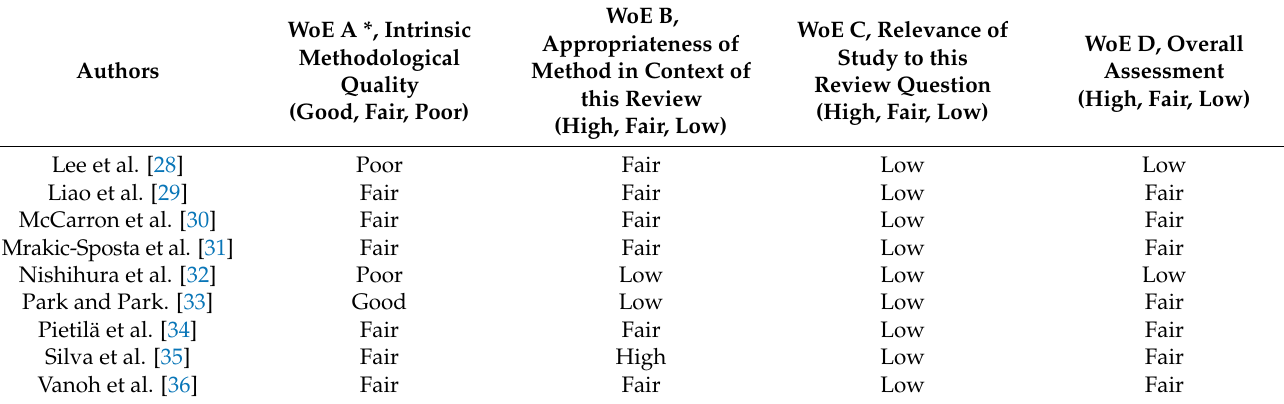
Table 2. Weight-of-evidence assessment of included